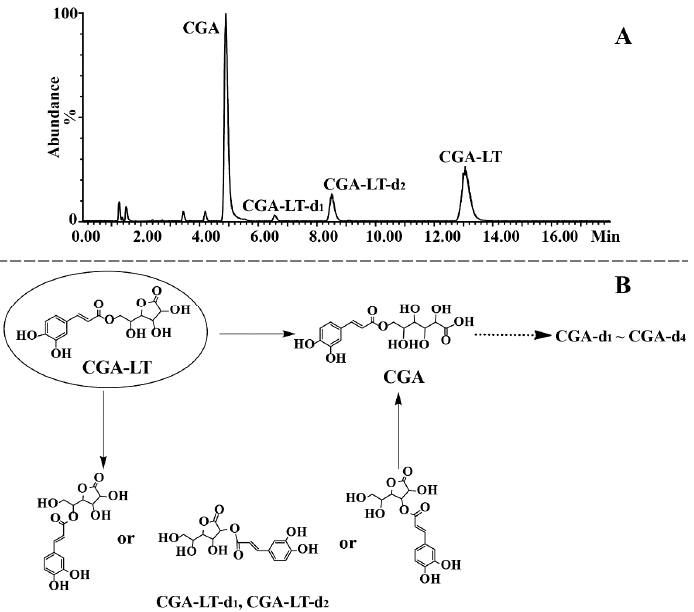
Figure 8. Representative TIC chromatogram of the reacted solution of CGA-LT in the negative ion mode ( A ) and proposed pathways of degradation for CGA-LT ( B ).